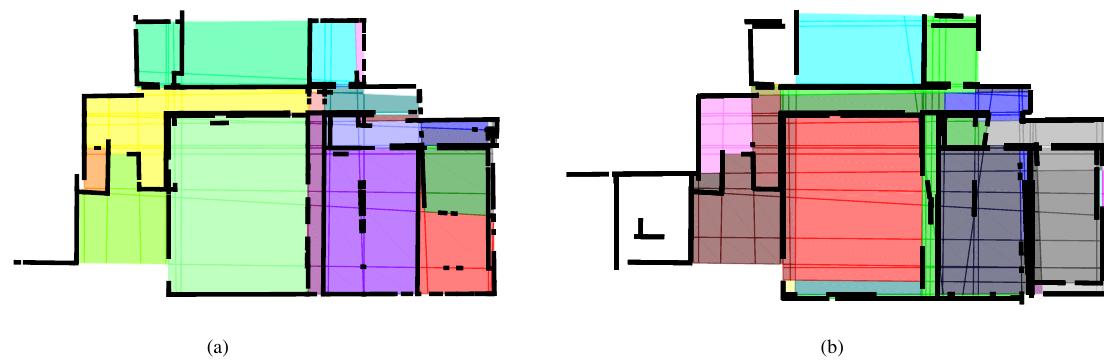
Figure 13. Dataset UoM : floor plans obtained with (a) the proposed method and (b) the method by (Magri and Fusiello, 2018). This figure is best viewed in